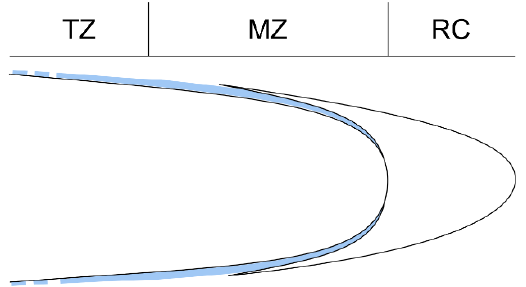
Figure 1. Localization of the pellicle (light blue) along the root proper, the pellicle becomes thinner and gradually disintegrates (dashed line) above the transition zone. RC root cap, MZ meristematic zone, TZ transition zone.